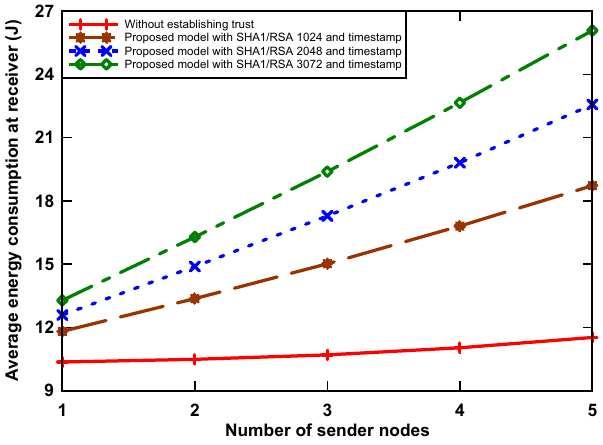
Figure 4. Average energy consumption of receiver node.